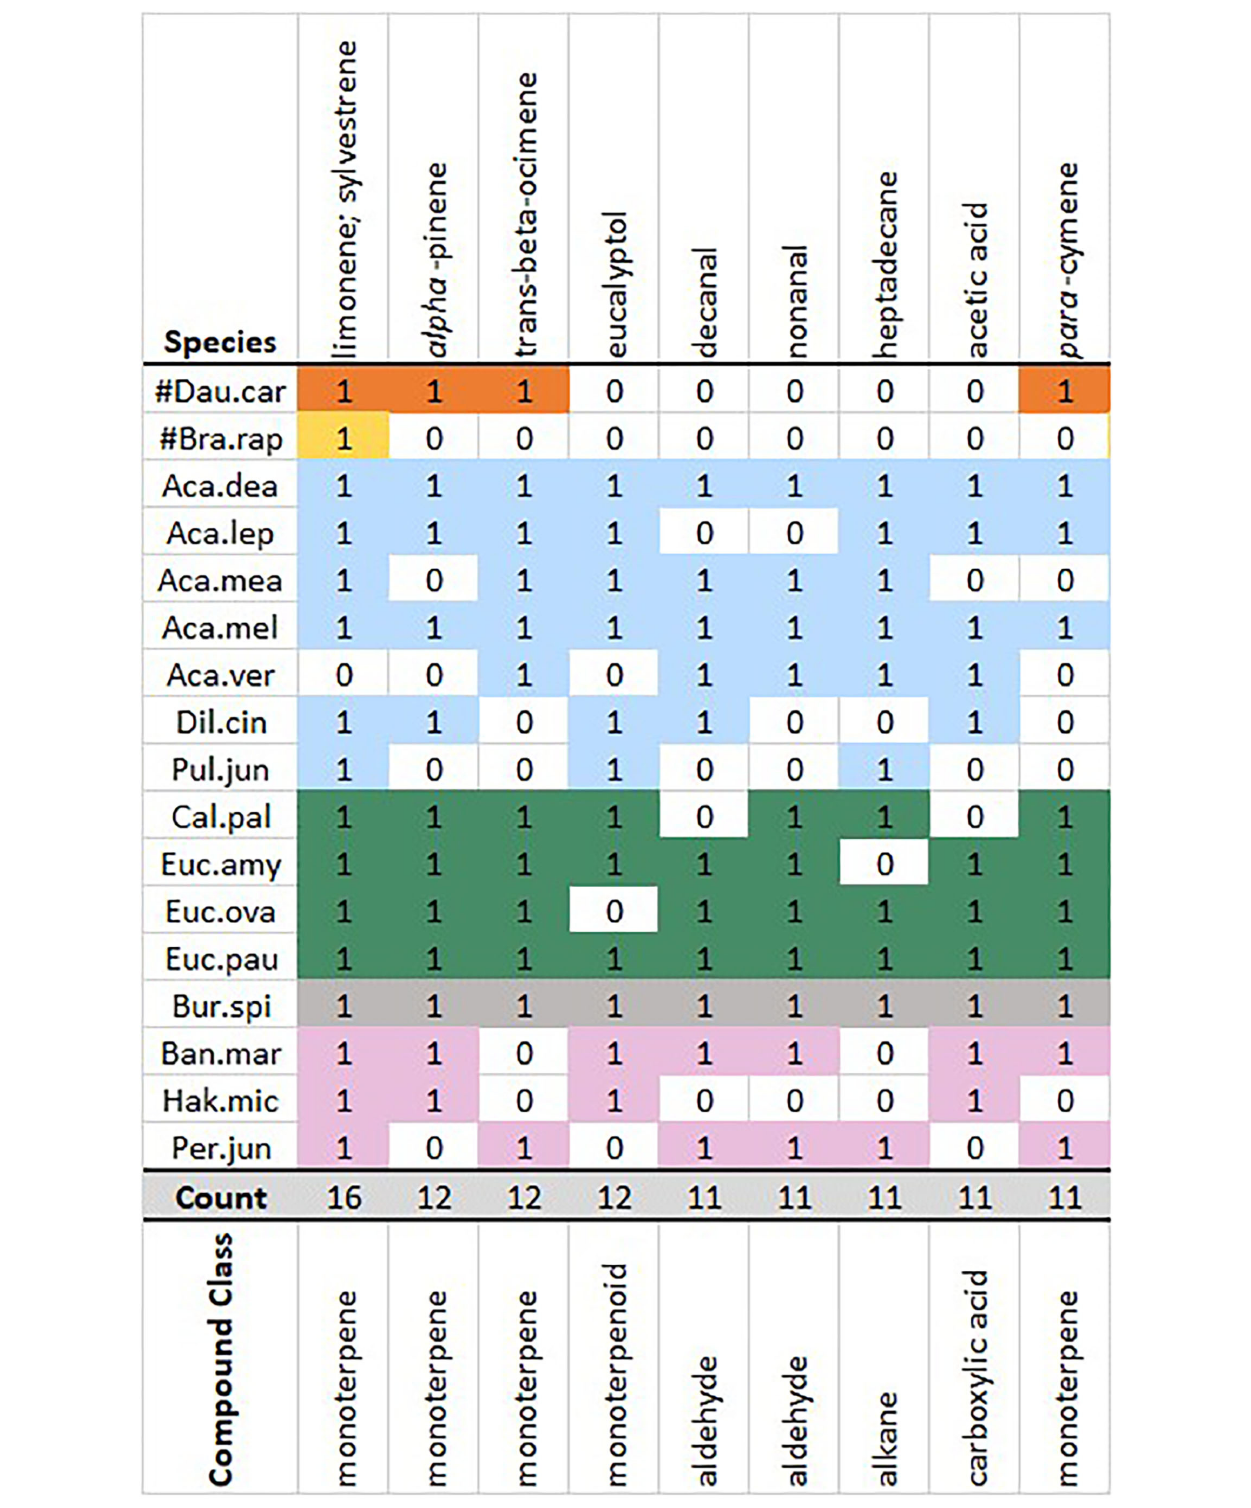
refer to Table 1 and Section Floral Scent Sampling and